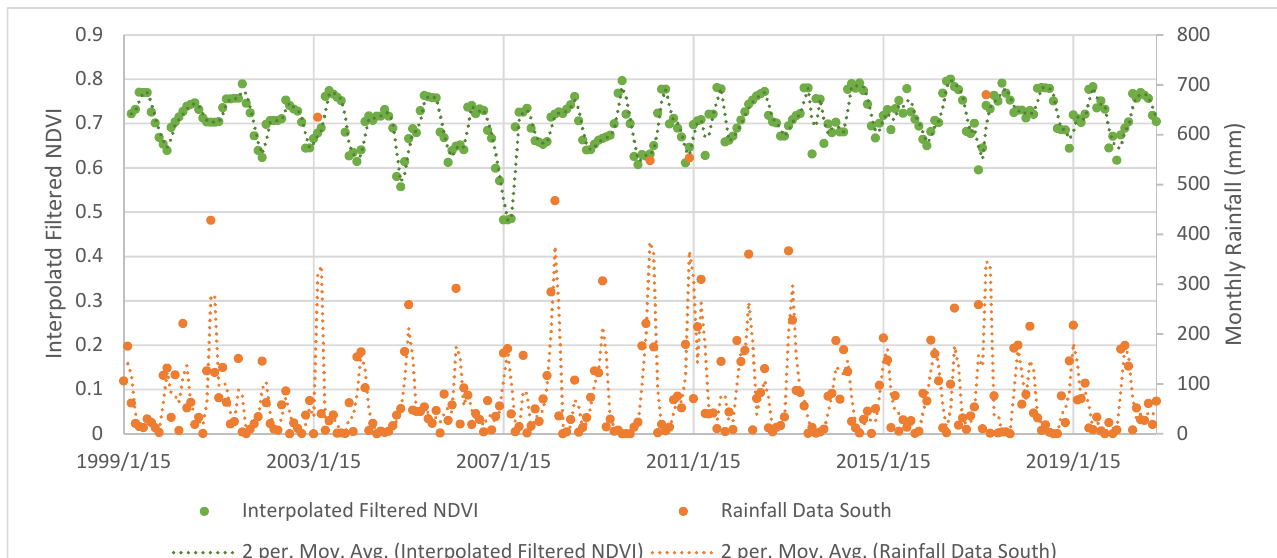
Figure 10. Interpolated, filtered NDVI and rainfall trendlines for the southern section of our study region, Herbert Creek bordering Shoalwater and Corio Bays Area Ramsar Wetland, rainfall data gathered from St. Lawrence Station (station number: 33065).